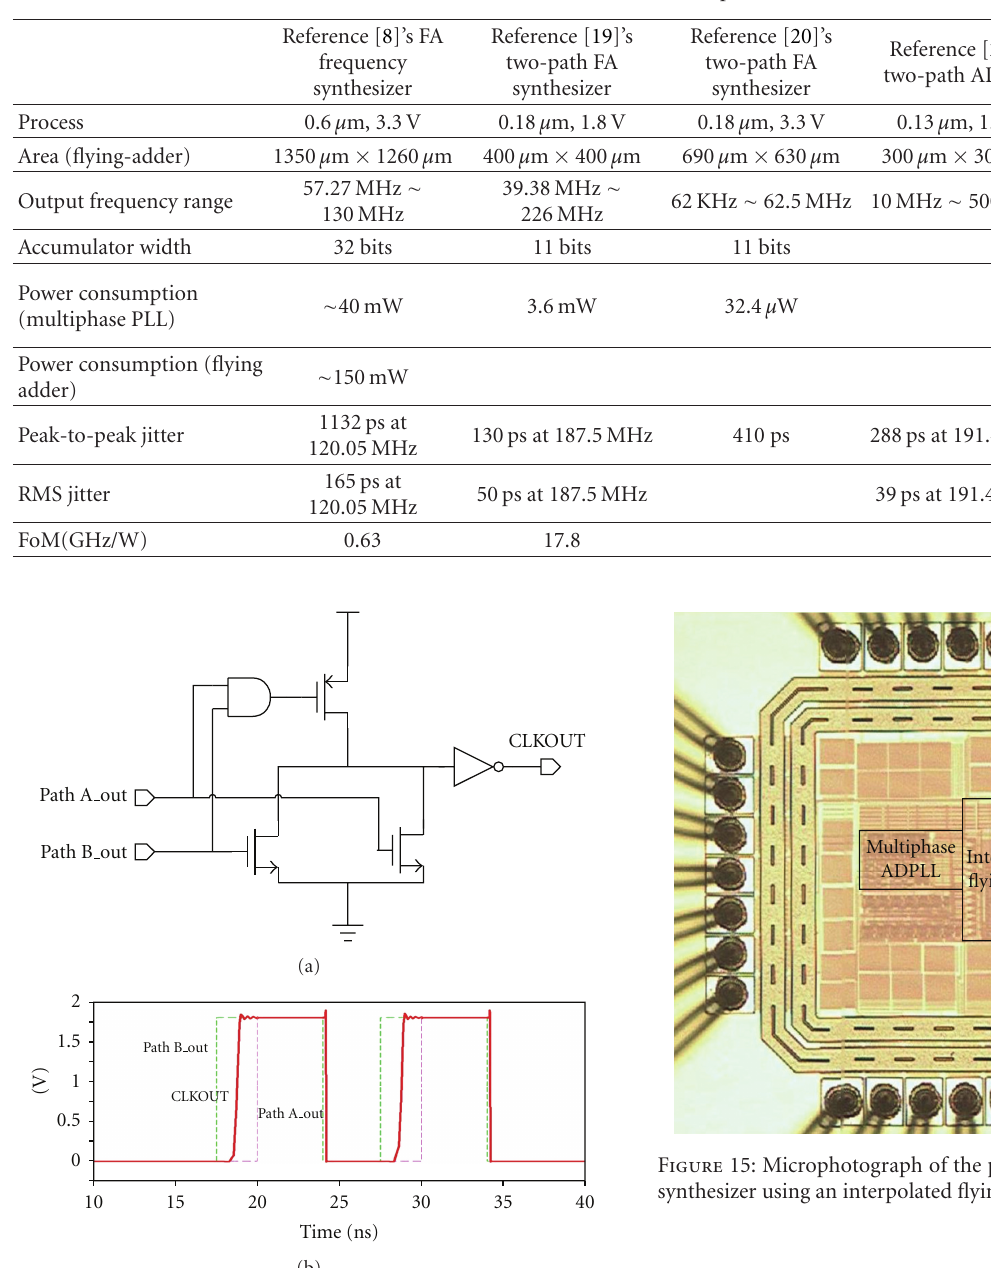
Table 3: Performance comparison.